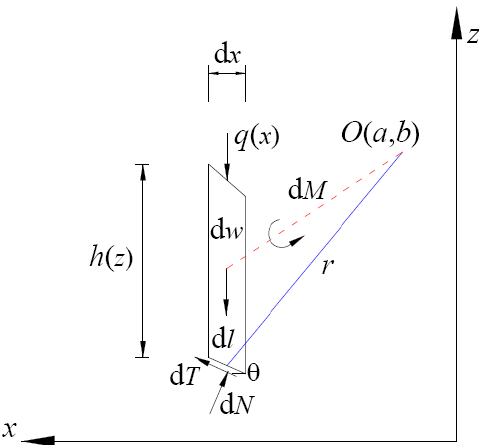
axis is θ , and the normal and shear forces on the bottom of the soil slice are d N and d T , respectively. The slip moment of soil slice is d M , and the surcharge is q ( x ).